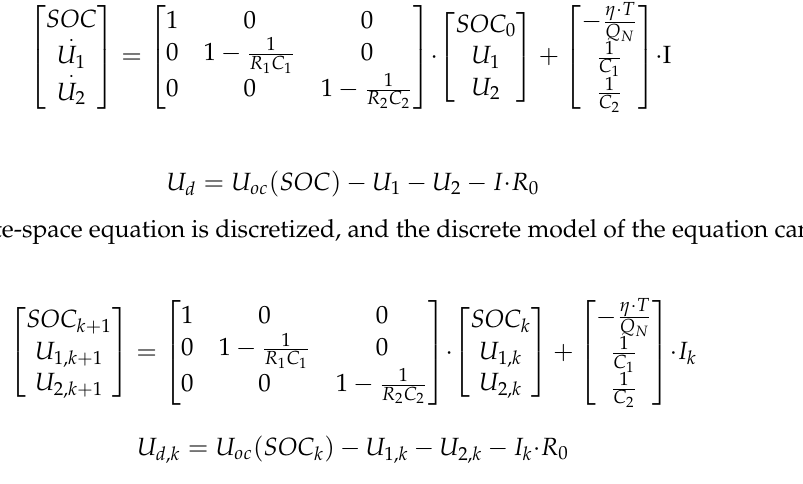
Figure 2. The operating temperature range of the battery is − 20 degrees Celsius ~50 degrees Celsius. In the experiments, the lithium-ion battery is tested with 1C pulse discharge, and the sampling time was 1 s/ time, the experimental temperature is under room temperature around 25 degrees Celsius. More details about how to use the Arbin BT-ML-100V100A test rig can be seen in the user’s manual of Arbin Company.